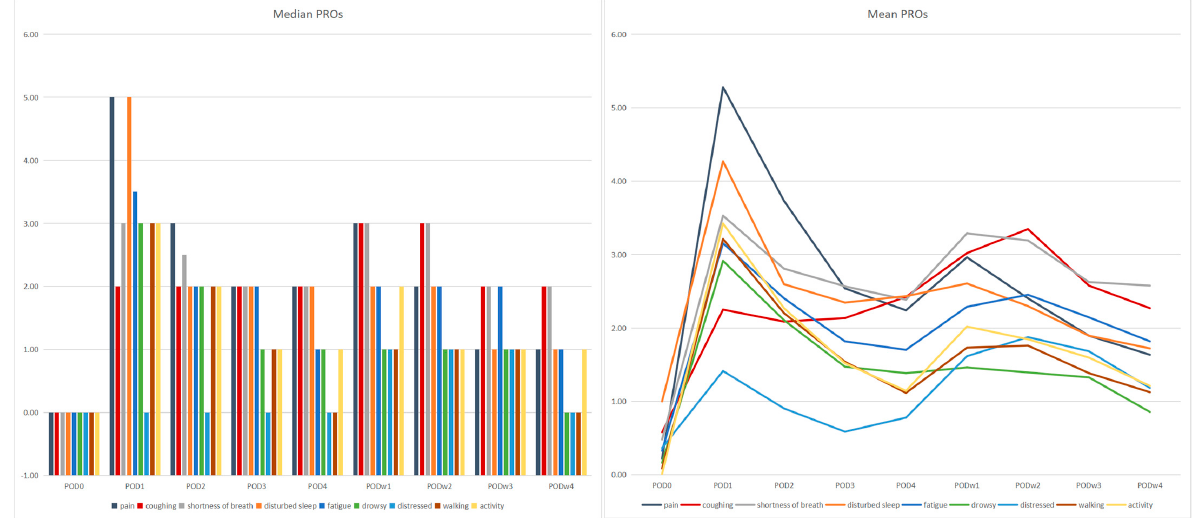
Figure 1. The median and mean values of each PRO score (pain, coughing, shortness of breath, disturbed sleep, fatigue, drowsy, distressed, activity, walking) at each data collection time point.